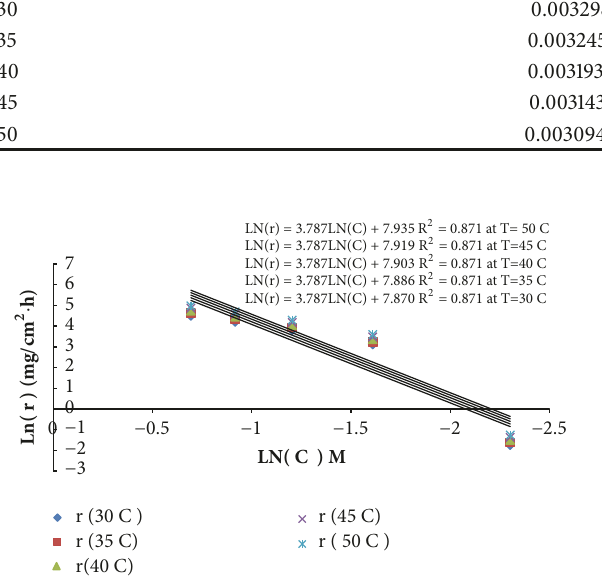
Figure 2: ln(r) versus ln(C) of mild steel in sulfuric acid at different concentration (0.1–0.5 M) and at different temperature (30-50 ∘ C).